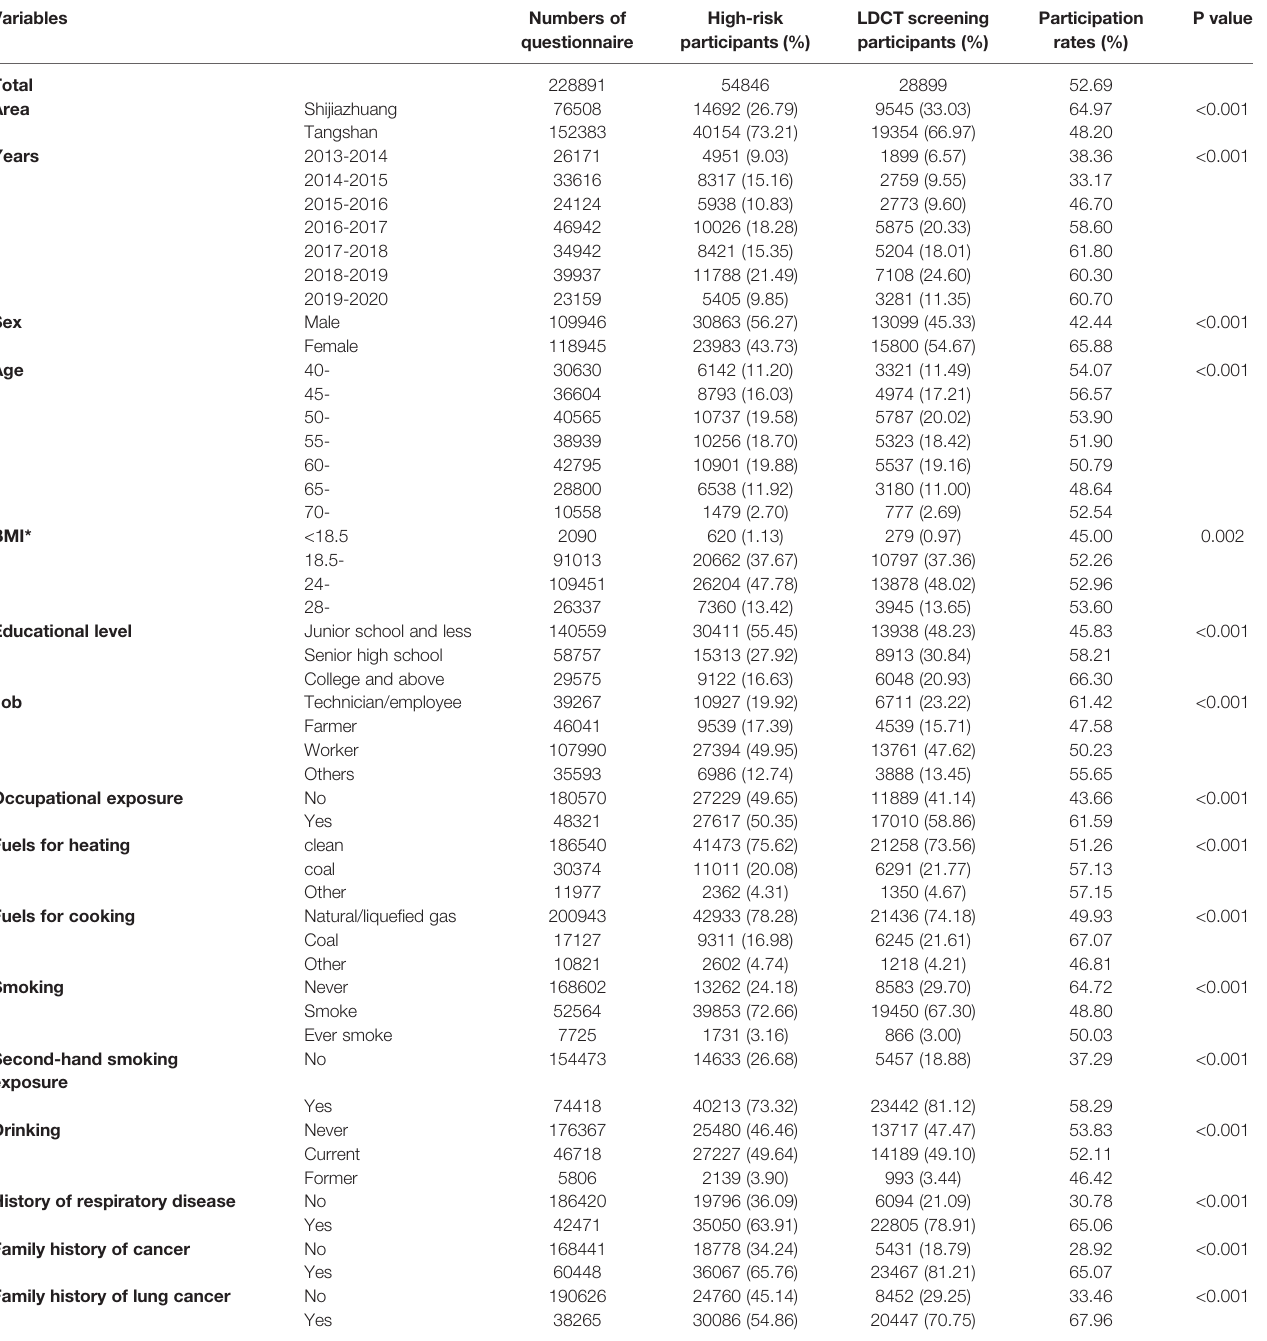
TABLE 1 | Characteristics of the study population and participation rates between different